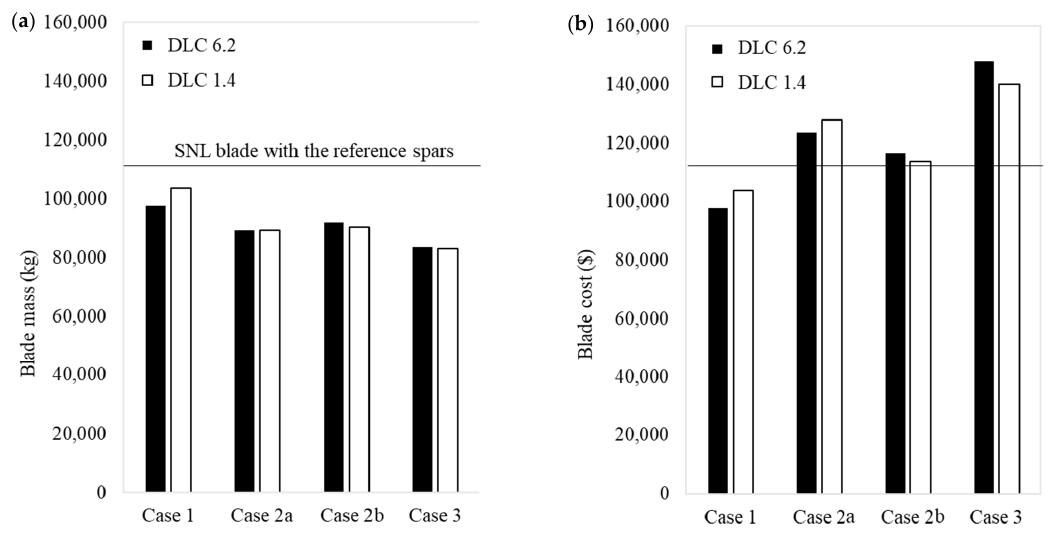
Figure 7. The optimization results for ( a ) blade mass, and ( b ) blade cost.